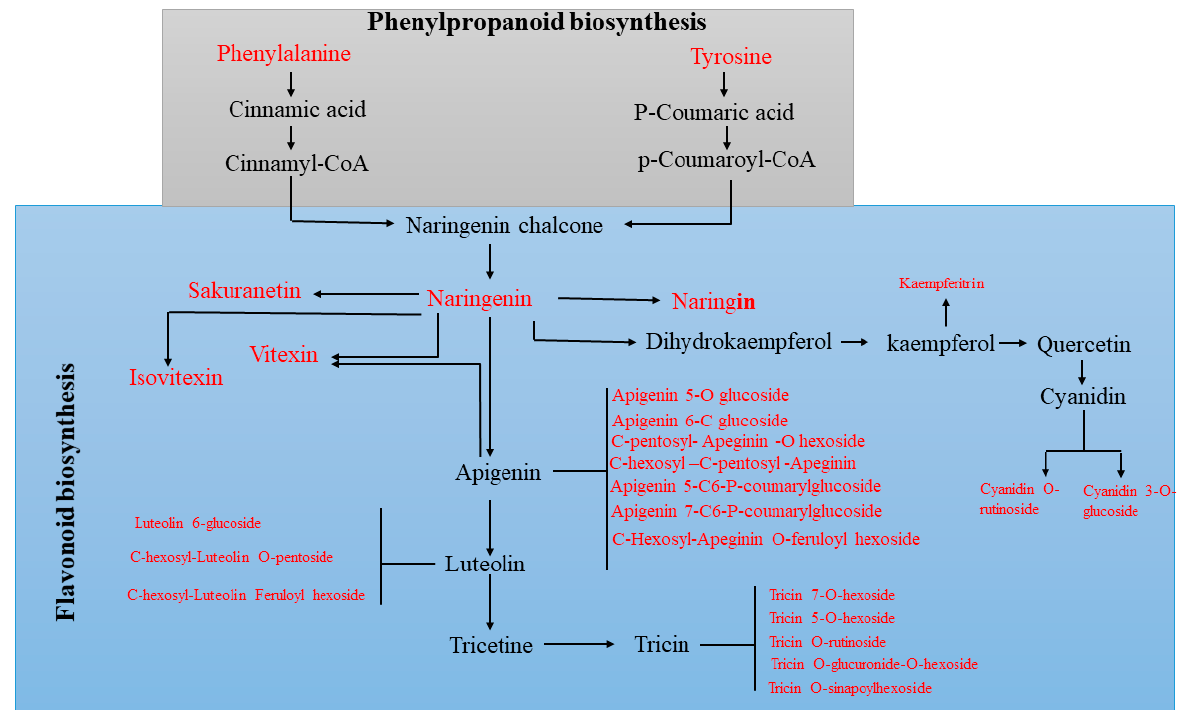
Figure 5. Modulation of phenylpropanoid and flavonoid biosynthesis pathways in date palm leaves under UV-B irradiation. Detected metabolites are indicated with red color.